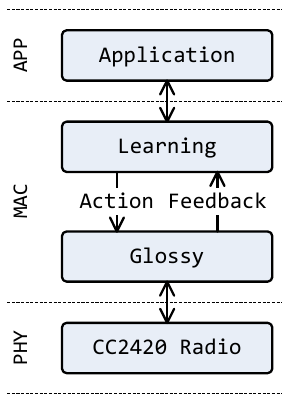
Figure 1. Protocol stack of LiM. LiM builds on Glossy and exploits an iterative learning scheme to select an action based on the feedback.